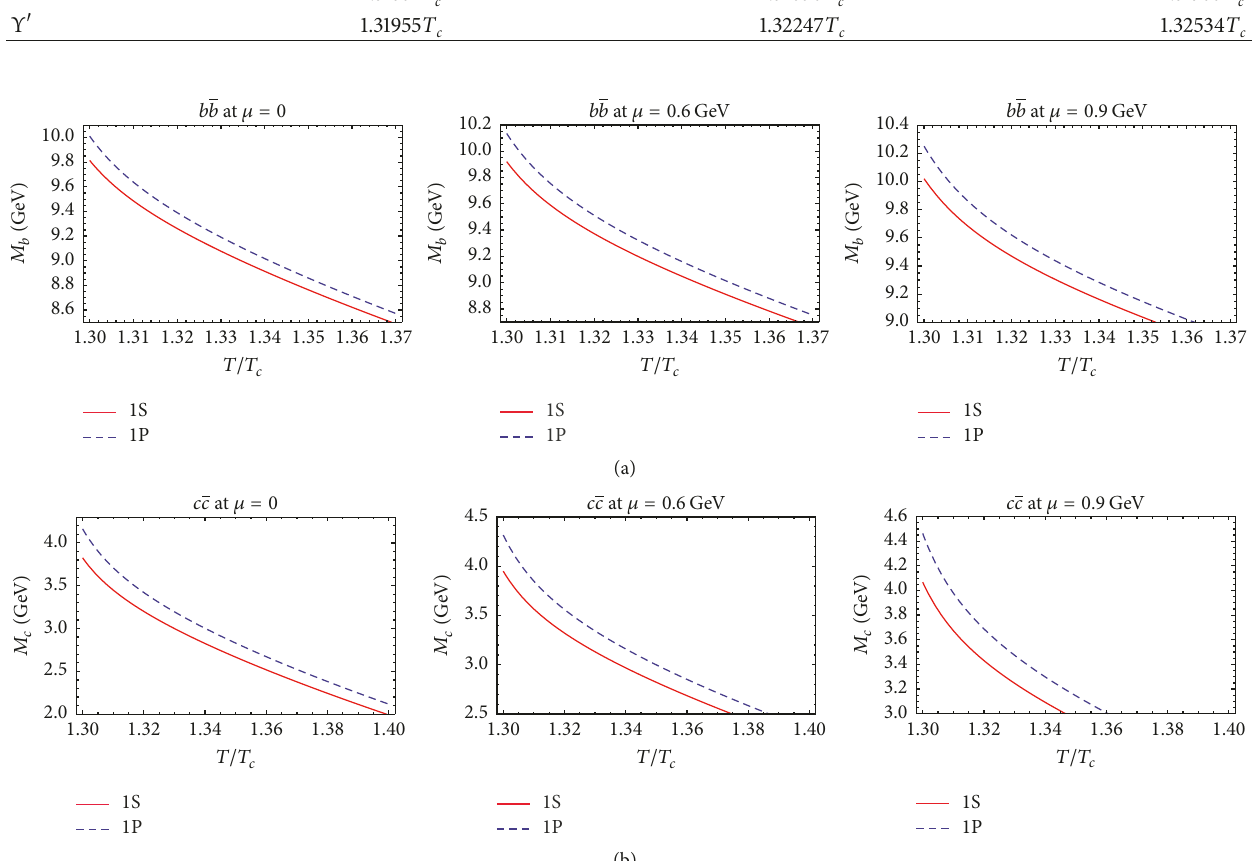
Figure 8: The mass spectra of heavy quarkonia are plotted as a function of temperature for 1S and 1P states, bottomonium in (a) and charmonium in